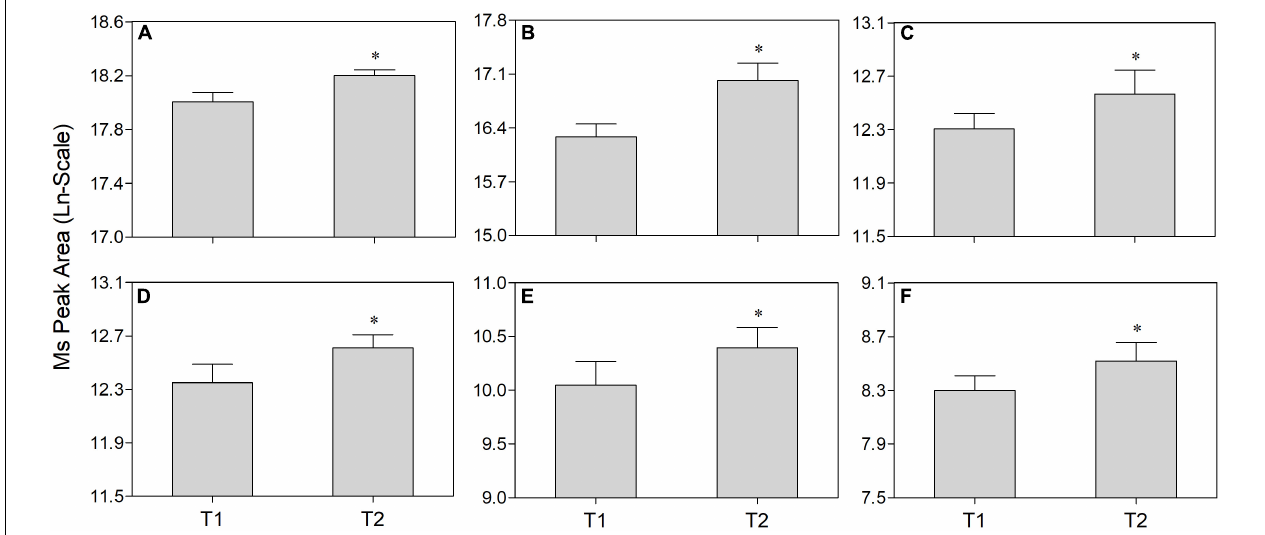
FIGURE 5 | Comparison of sucrose (A) , tagatose (B) , mannitol (C) , dulicitol (D) , lavandulol (E) , and perseitol (F) concentration in the phloem sap of navel orange between foliar-water (T1) and foliar- 10 B (T2) treatments. “ ∗ ” indicates significant difference between T1 and T2 treatments ( t -test, n = 4, P < 0.05).